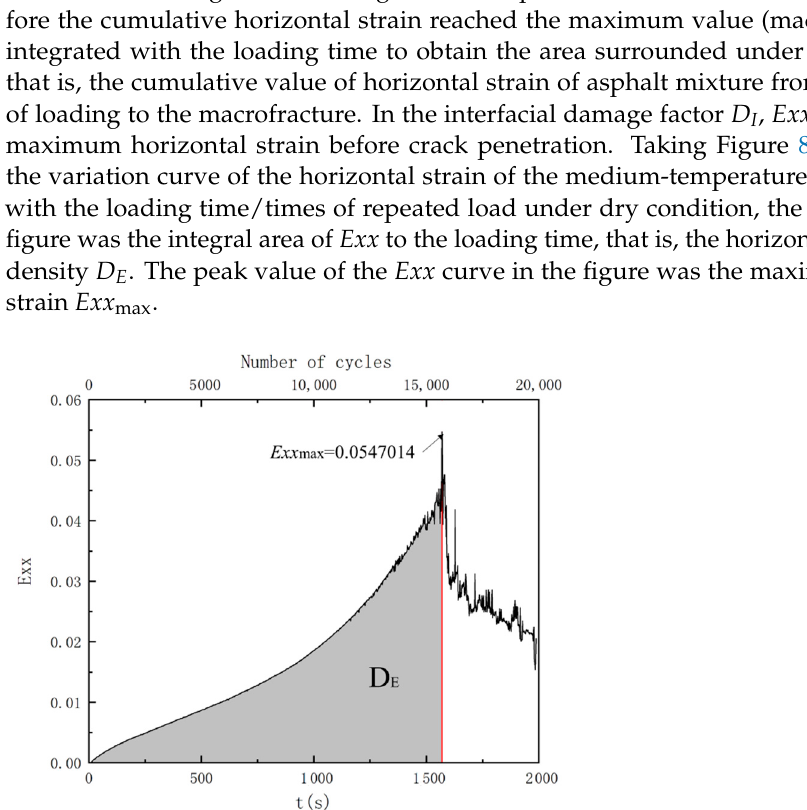
Figure 10. D I of CR mixture before and after immersion under medium temperature fatigue failure.